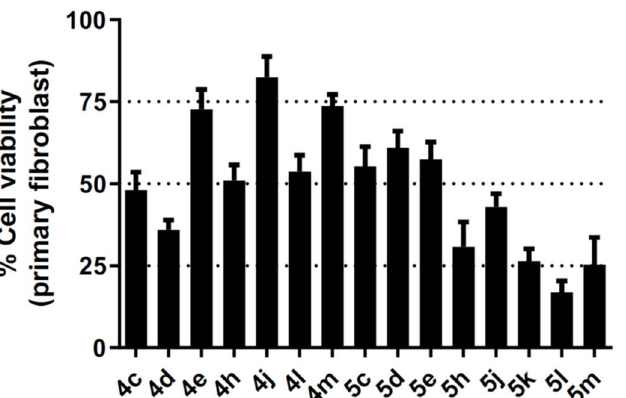
Figure 2. Determination of selective acridine-core naphthoquinone compounds in normal fibroblasts. Normal human gingival fibroblasts were treated with twice the calculated IC 50 (2 × IC 50 ) of the indicated compounds for 48 h and cell viability was determined by MTT assay. The IC 50 of each compound was previously calculated on SCC9 (OSCC) cells and are demonstrated in Table 1. Results from at least three independent experiments. Table 2. Characterization of the most selective acridine-core naphthoquinone compounds in other OSCC cells. The IC 50 (µM) of three different OSCC cell lines (SCC4, SCC9, and SCC25) for compounds 4e , 4j, and 4m were calculated. S.I. = IC 50 of the compound in cells of normal oral fibroblasts/IC 50 of the same compound for each oral cancer cell line.